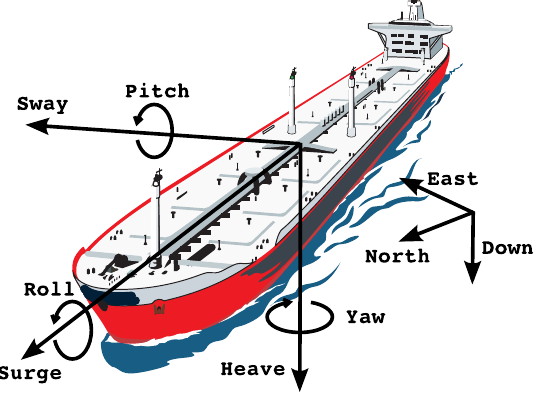
Figure 1: Definition of